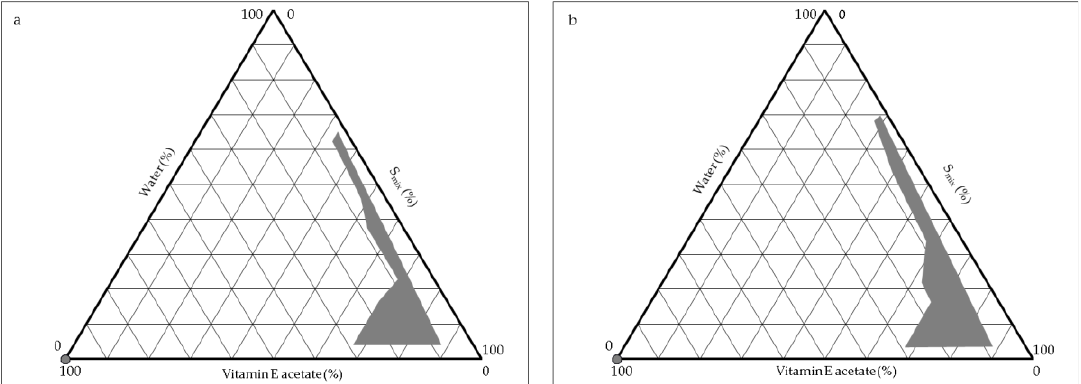
Figure 2. Pseudoternary phase diagrams of the systems composed of oil, surfactant/co-surfactant (S mix ) and water. The oil phase is vitamin E acetate; S mix is a mixture of Labrasol ® /Transcutol ® P 2:1 v/v ( a ) and 3:1 v/v ( b ). The grey regions indicate transparent and homogenous microemulsions; in the remaining regions, coarse turbid emulsions or phase separated systems were observed.